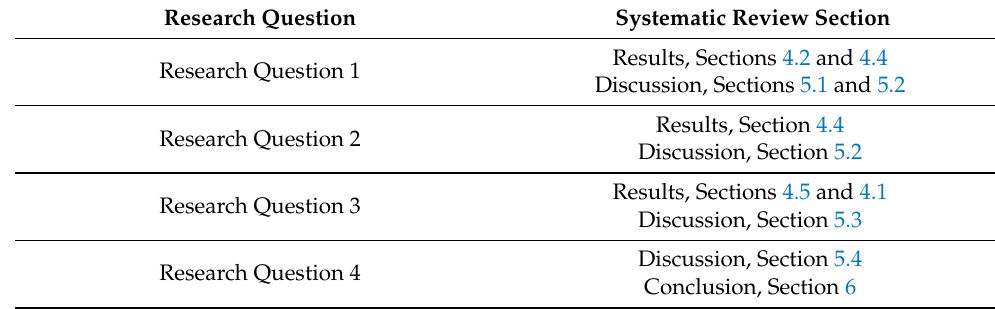
Table 4. Research questions and